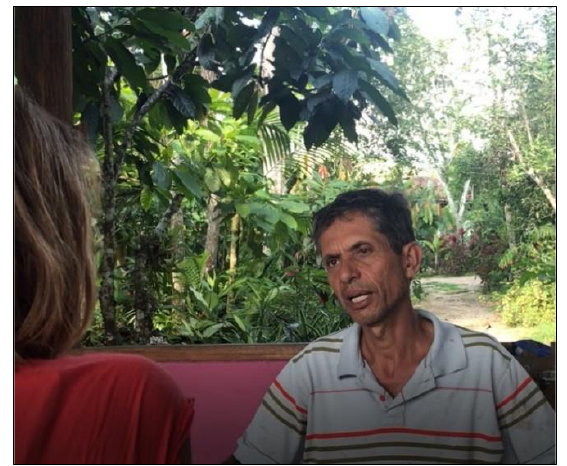
Figure 6. Henrique Souza, Fazenda Ouro Fino